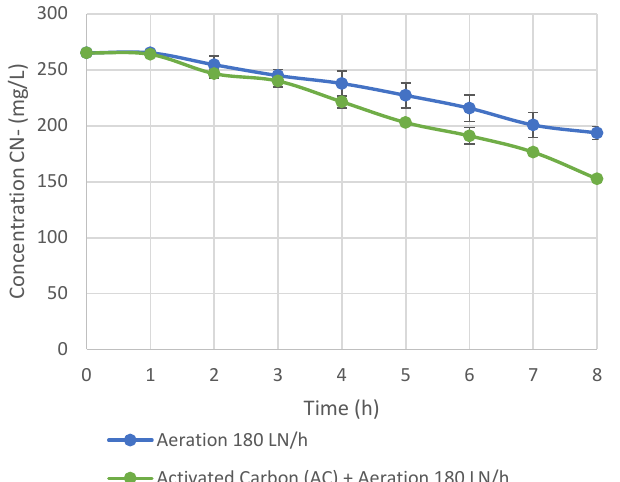
Fig. 2: Cyanide oxidation test with the presence of aeration and with the presence of activated carbon (15 g/L) and aeration, test time 8 h